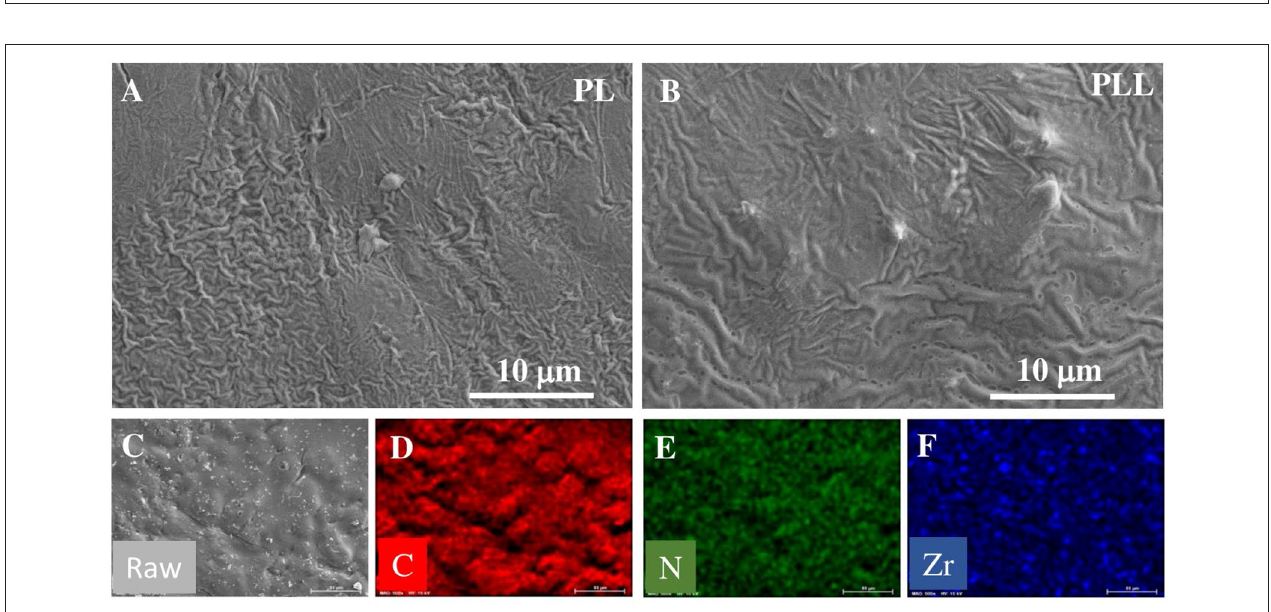
FIGURE 2 | SEM images of solid polymer membrane: (A) PL electrolyte, and (B) PLL electrolyte. EDX mapping of PLL electrolyte: (C) Electrolyte membrane, (D) C element, (E) N element, and (F) Zr element.